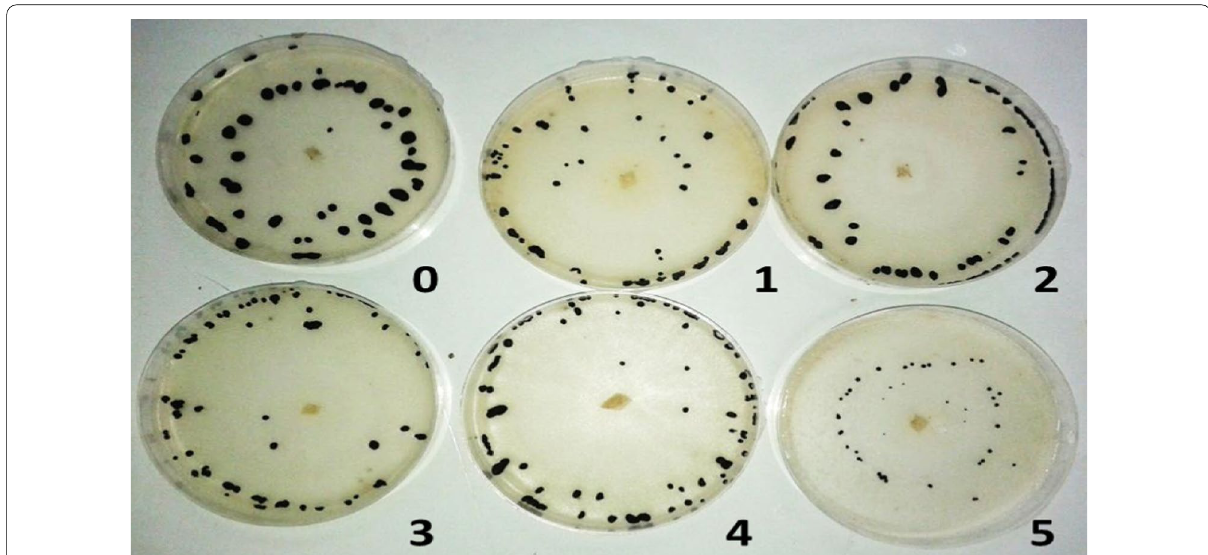
Fig. 2 Effect of nanoemulsions formulations (5000 ppm) on sclerotia formation of B. cinerea 10 days at 27 (0), treatment with nanoemulsions of clove (1), black seed (2), nanoemulsions formulations of clove (5),